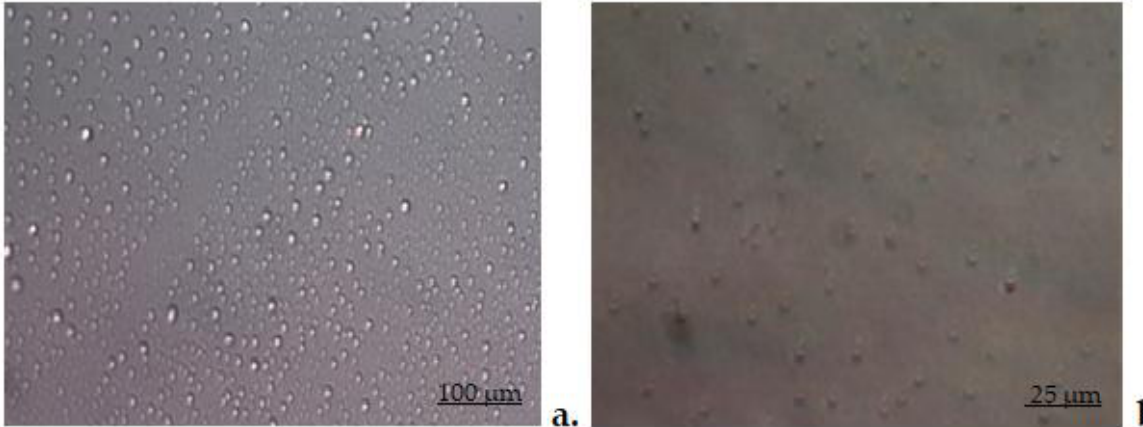
Figure 2. DIC (20 × ) optical microscopy images of chitosan-free DCF-ves ( a ) and chitosan-stabilized and dialyzed DCF-ves ( b ).